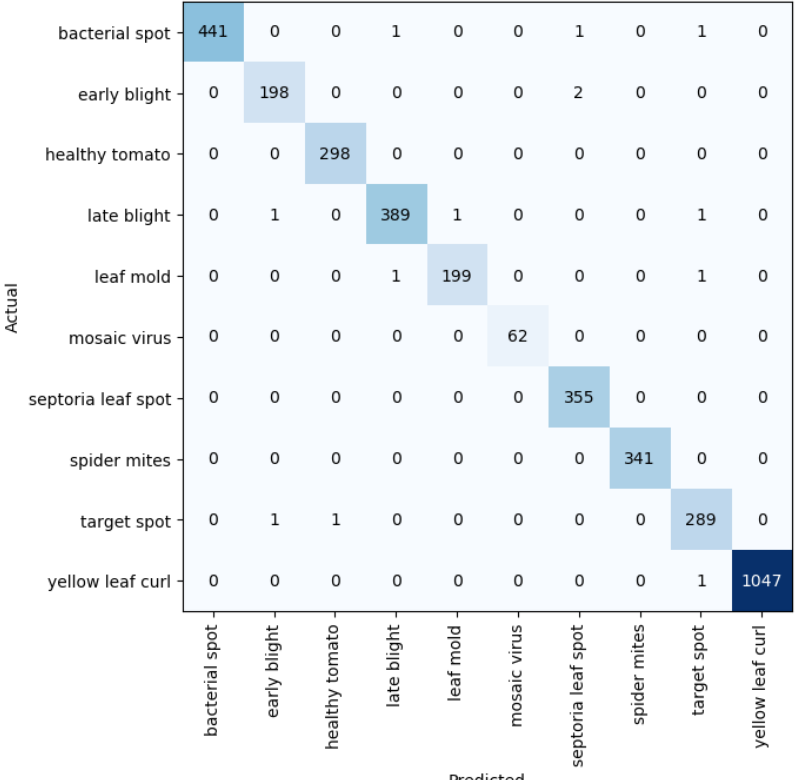
Figure 5. Confusion matrix for network depth = 152.